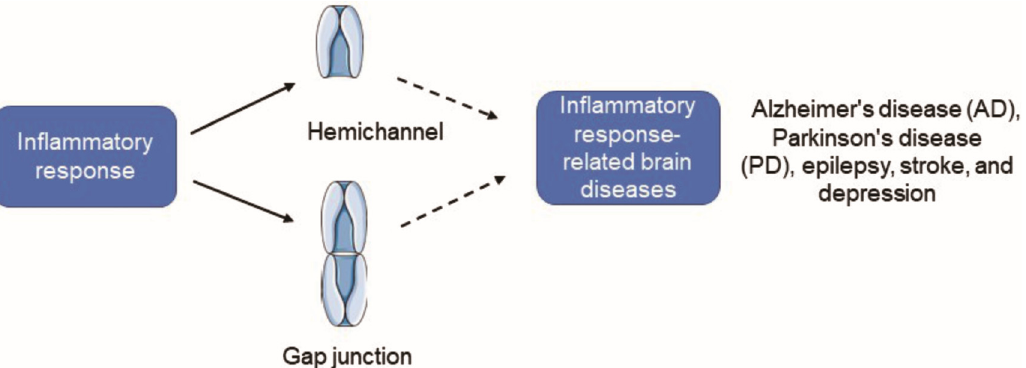
Figure 1. Cx43 HC activity is increased and Cx43 GJIC is inhibited under inflammatory